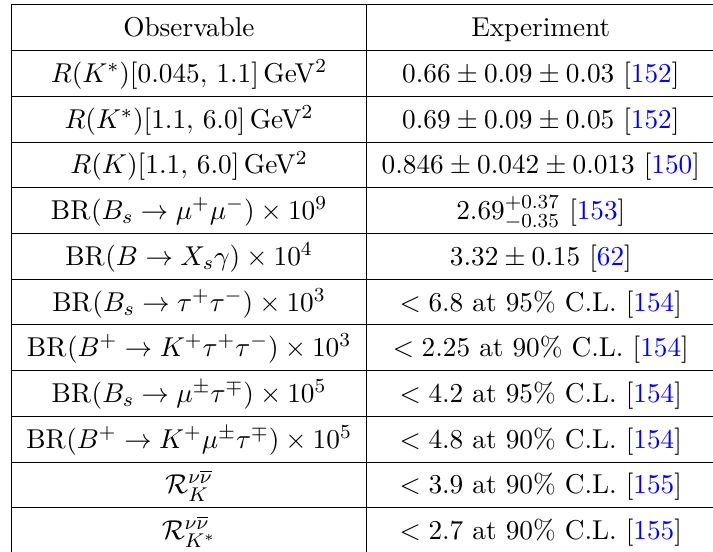
Table 1 . Experimental measurements of FCNCs observables and bounds for rare B decays consid- ered in our study. The R νν parameters are related to b → sνν transitions as introduced in eq. (4.6) K ( ∗ ) in [70]. We also include all the angular distributions and branching fractions of B 0 → K ∗ 0 µ + µ − decays, the branching fractions of both B s → φµ + µ − and B + → K + µ + µ − with measurements provided by the HEPLikeData repository